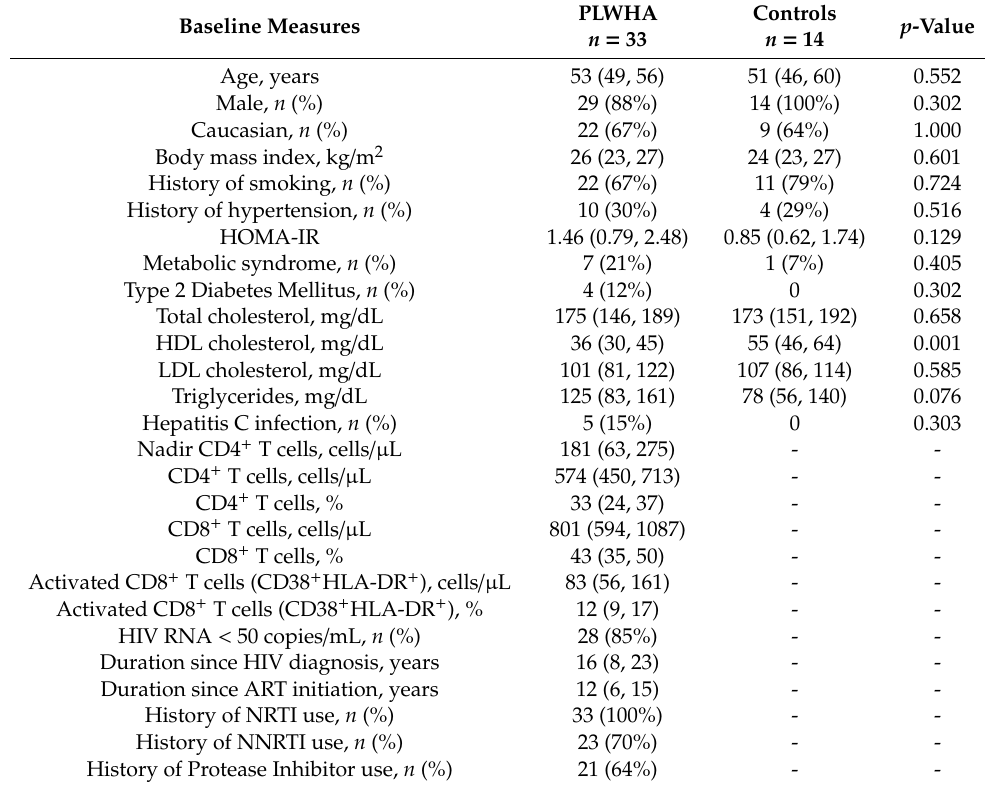
Table 1. Comparison of baseline measures of study participants 1